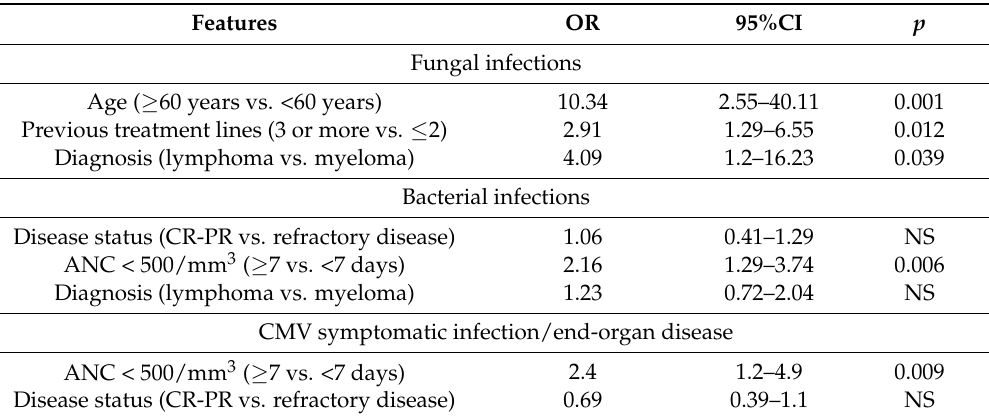
Table 5. Multivariate analysis of risk factors for CMV, fungal and bacterial infections in our study cohort of 347